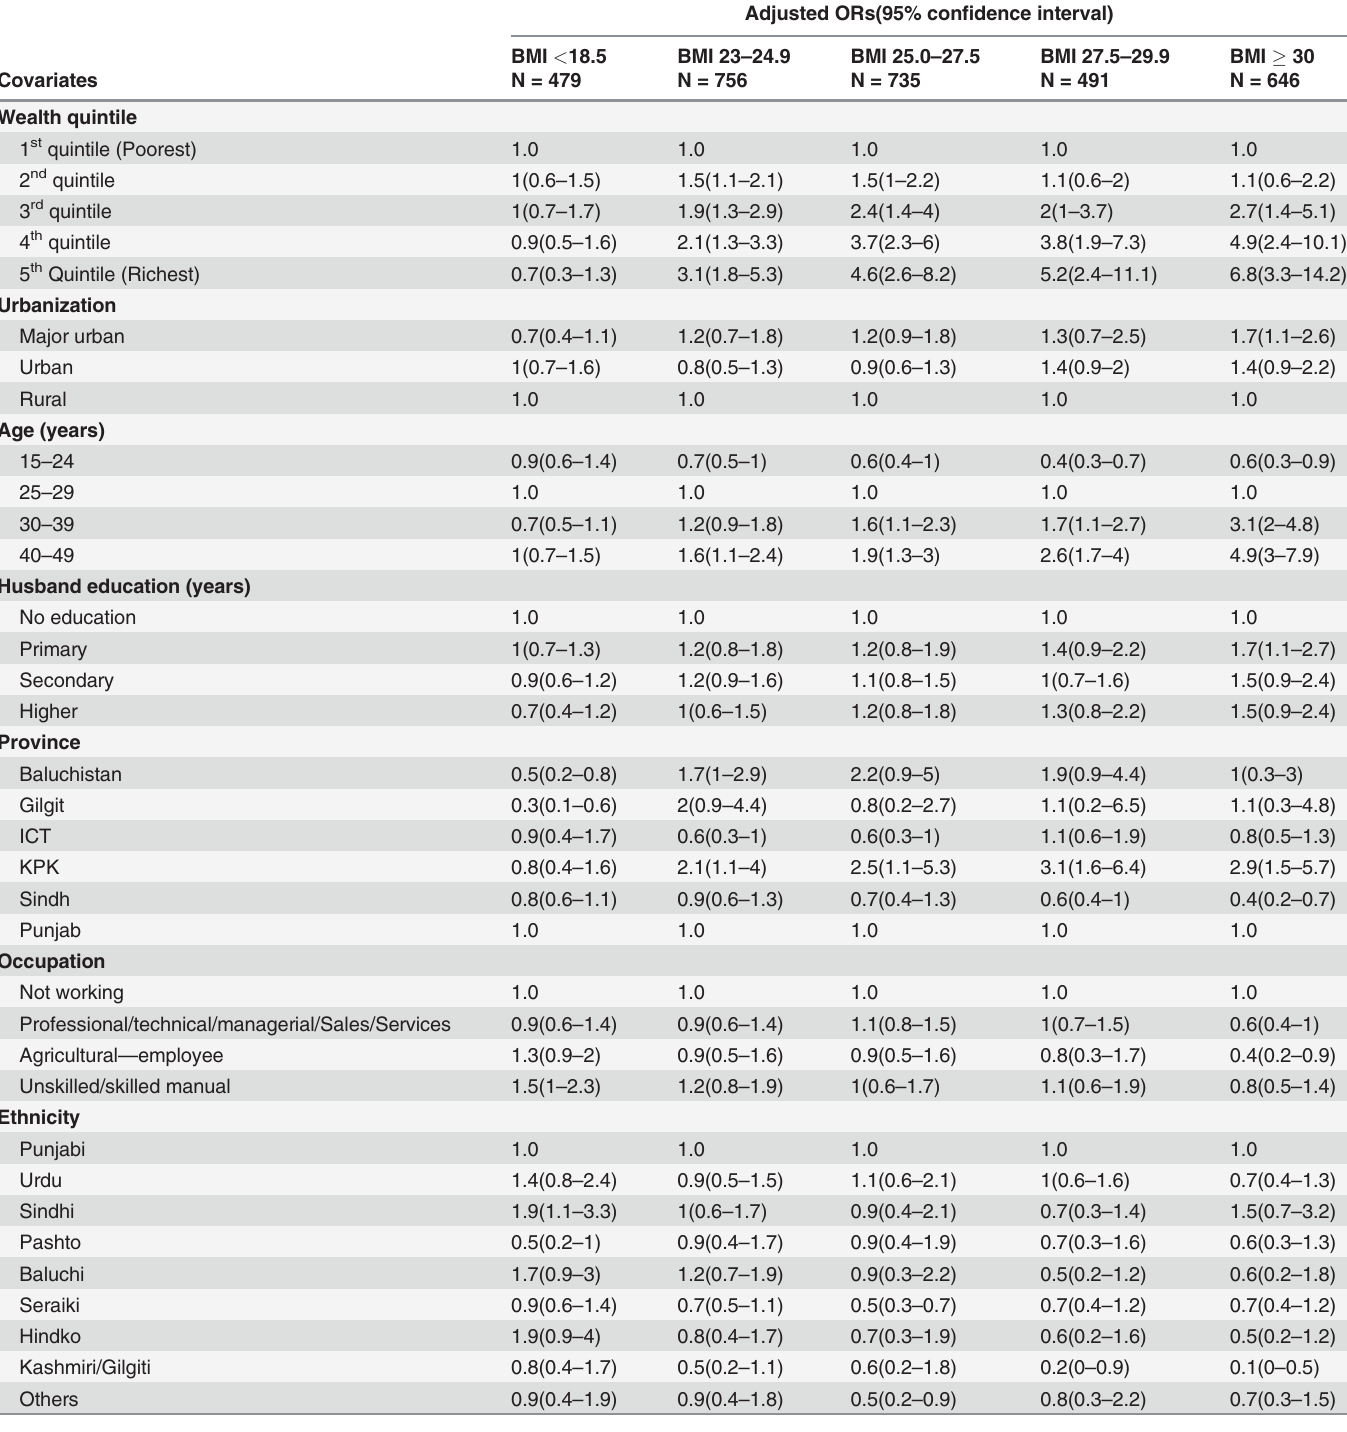
Table 2. Multivariable model for association of household socio-economic position and other participants ’ characteristics with categories of BMI among women, Demographic and Health Survey of Pakistan 2012 –